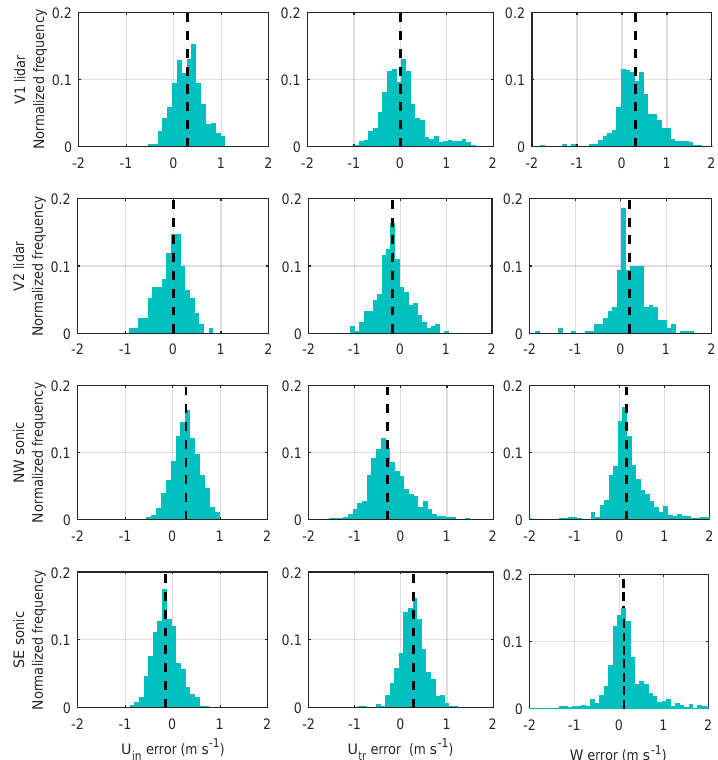
Figure 8. Histograms of the velocity difference in the retrieval of the 3-D wind velocity from triple RHI scans performed for virtual tower 1 and all the heights, which are obtained through comparison with measurements performed with the lidar profilers V1 and V2, and the NW and SE sonic anemometers. Columns represent different velocity components; rows represent different instruments. Median is reported with a vertical dashed black